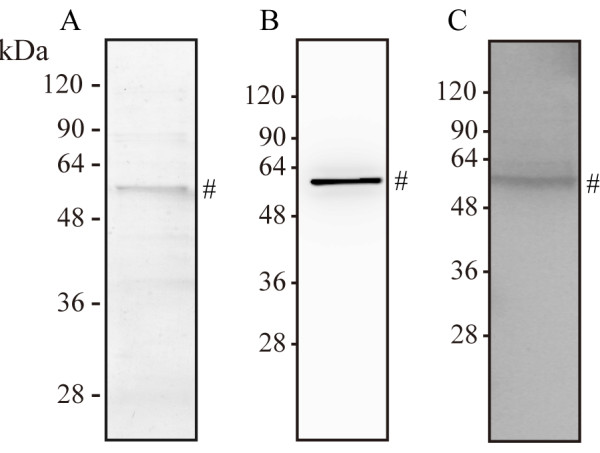
SDS-PAGE and immunoblotting of recombinant leptospiral HADH. (A) The rHADH with His-tag was produced by E. coli and purified by cobalt resin. In total, 1 μg of the protein was run by SDS-PAGE and CBB staining. (B) Anti-His-tag antibody and (C) anti-L. interrogans pAb detected the protein. Sharp signs indicate recombinant protein bands of 52 kDa. These experiments were repeated three times, and the representative data are shown in this figure.